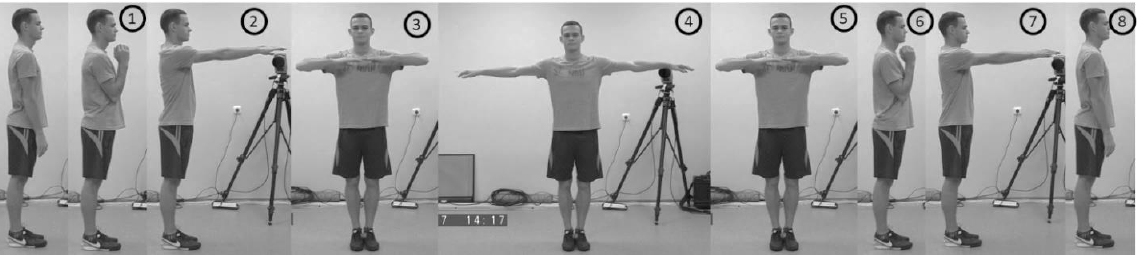
Figure 2. Motion test for the arms.